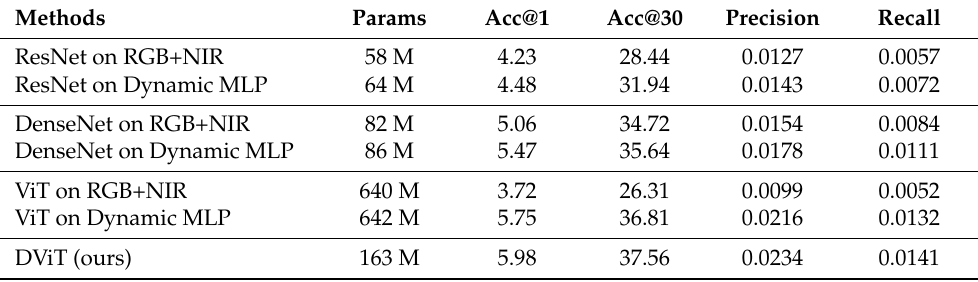
Table 8. For the validation set: the top-1 accuracy, top-30 accuracy, precision, and recall metrics comparison of the DViT with the image-only and multimodal fusion Dynamic MLP using GeoLife- CLEF